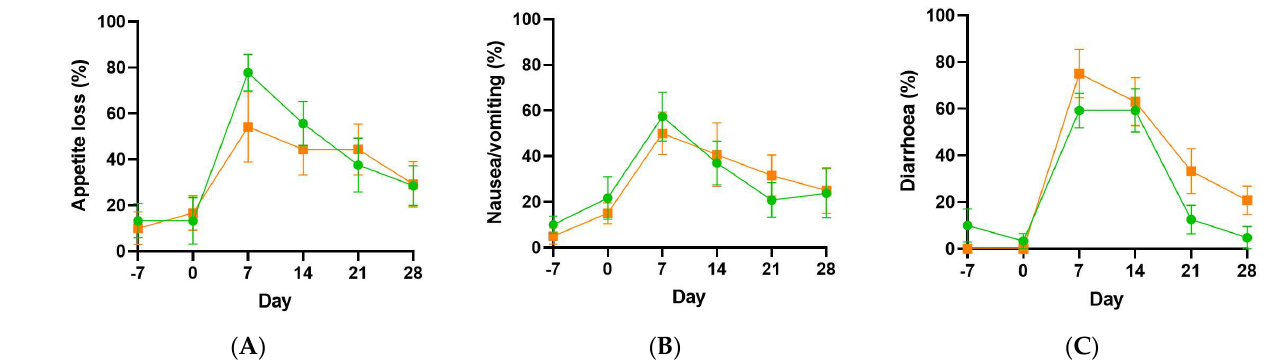
Figure 4. Gastrointestinal symptoms in the vitamin C and placebo groups. Appetite loss ( A ), nausea/vomiting ( B ) and diarrhoea ( C ), as determined by the EORTC QLQ. Placebo group, green circles; vitamin C group, orange squares.